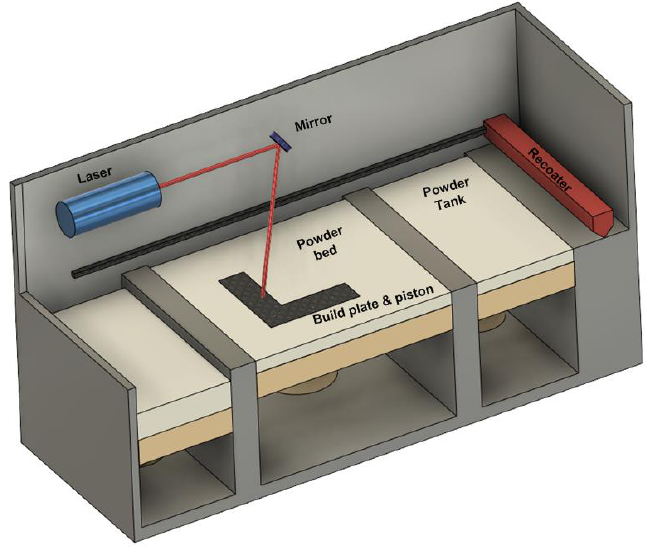
Figure 1. Schematic representation of the PBSLP process.